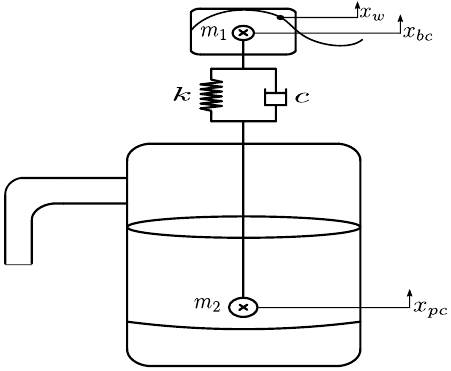
Figure 8. Schematic diagram of the